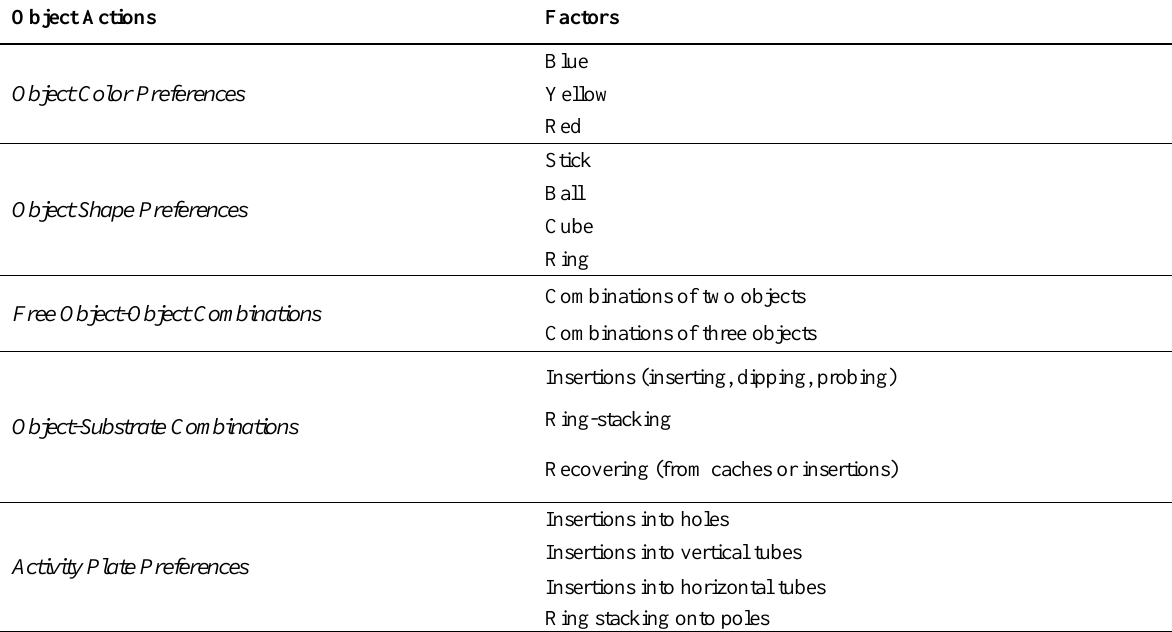
Subjects’ Object Actions that were used for Analysis Object